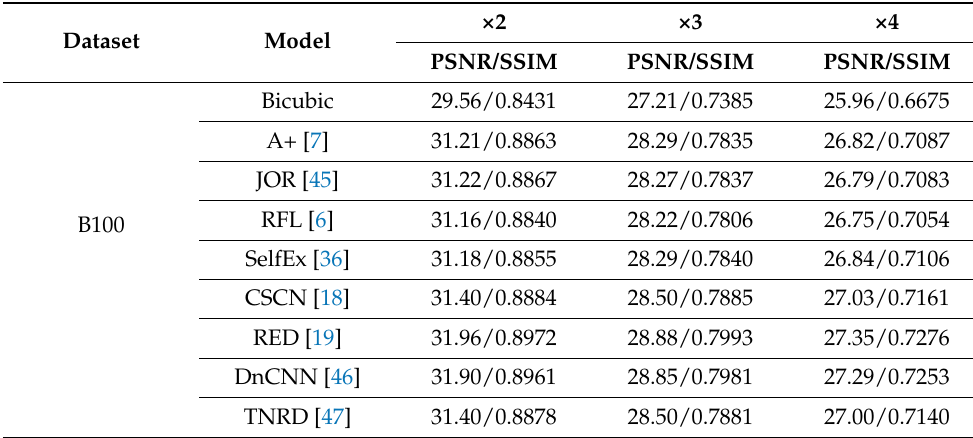
Table 4. PSNR and SSIM of different techniques with scale factors of ×2, ×3, and ×4 on B100.